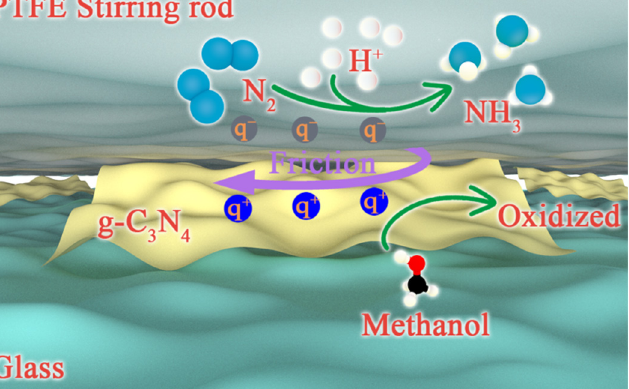
Figure 9. The schematic diagram for the tribocatalytic mechanism of g-C 3 N 4 .